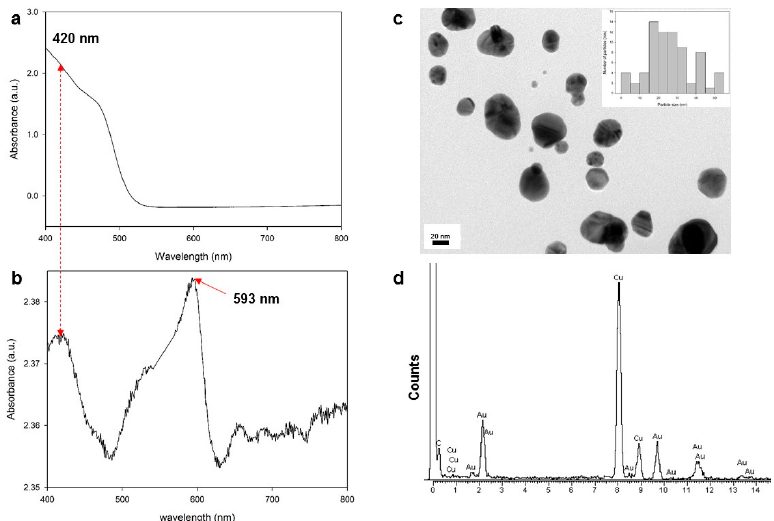
Figure 1. Au nanoparticles formed through reduction of Au(III) salt by polydimethyl siloxane (EDMS) after 30 min of stirring. ( a ) UV–Vis spectrum of 7.4 × 10 − 5 mol Au salt in pTFH; ( b ) UV–Vis absorbance spectrum of Au nanoparticles after addition of EDMS (the red dotted line is included for ease of comparison between ( a ) and ( b )); ( c ) transmission electron micrograph, inset shows corresponding